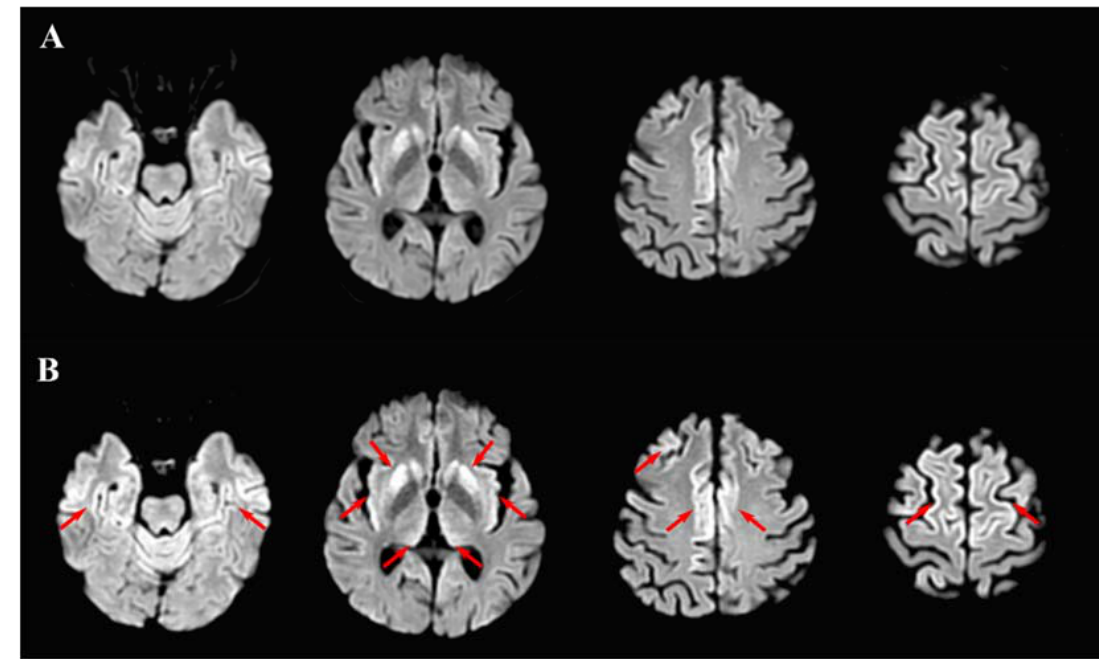
Figure 1. Brain MRI. Diffusion ‐ weighted images displaying a hyperintense signal in the cortical mantle over the frontal, parietal, insular, and cingulate cortices, as well as bilateral putamina, caudate nuclei, and thalamus pulvinar before the SARS ‐ CoV ‐ 2 infection ( A ). Repeated MRI performed nearly one month after the onset of SARS ‐ CoV ‐ 2 infection was marked by a more enhanced signal (arrows) over the same regions ( B ).